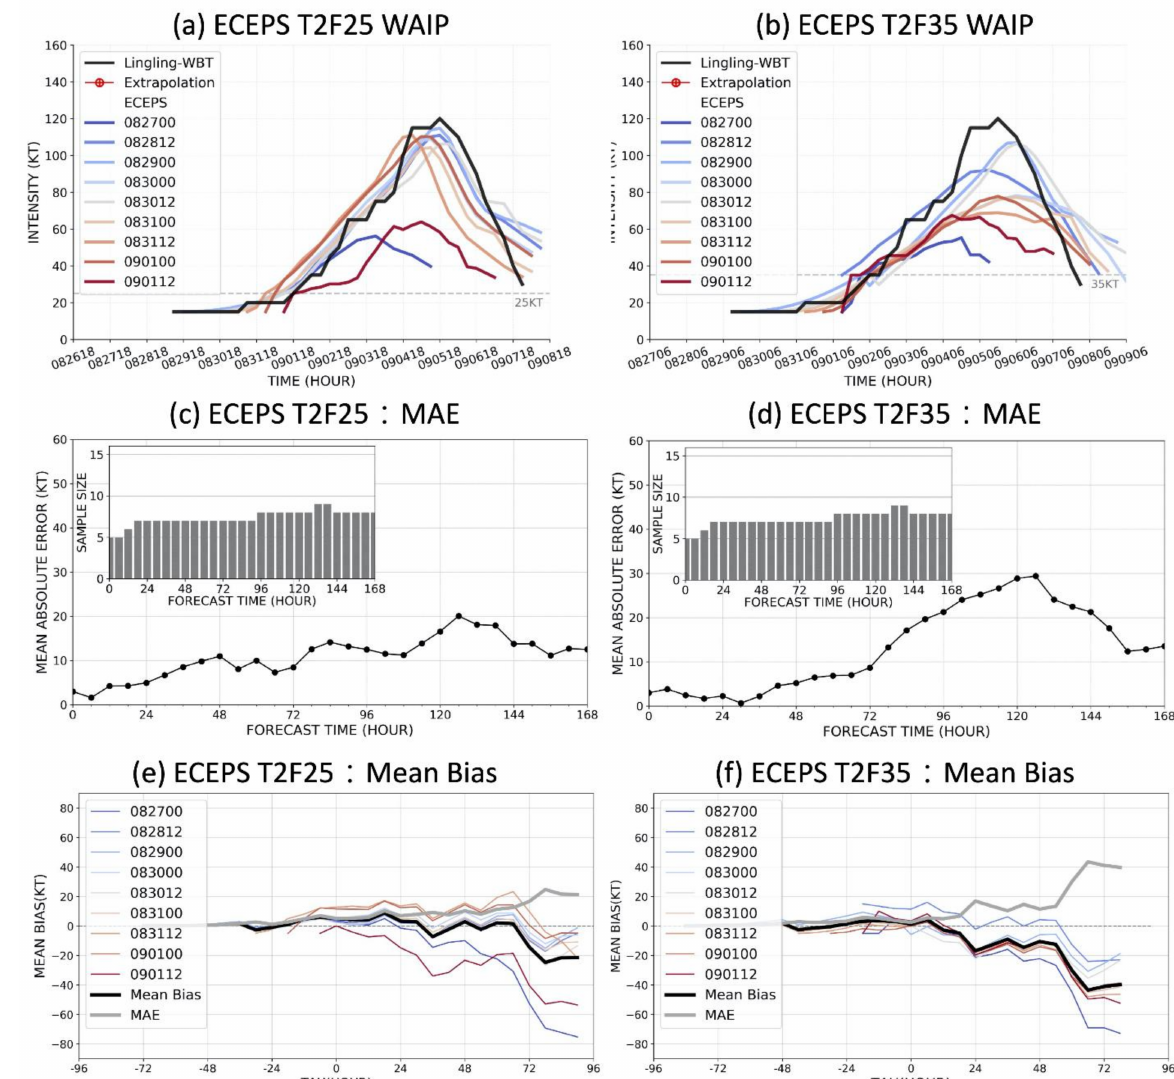
Figure 4. Pre-Lingling circulation modified WAIP intensity (knots) forecast verifications for the ECEPS-predicted T2F (25 kt) in left column and the T2F (35 kt) in right column: ( a , b ) Nine intensity forecasts (see initiation MMDDHH times in inset) versus JTWC WBT intensities in black line; ( c , d ) Intensity Mean Absolute Errors (MAEs) for the sample sizes indicated in the insets; and Mean Bias errors of the individual forecasts (see MMDDHH times in inset) relative to the JTWC WBT for forecast times relative to the ( e ) T2F (25 kt) and ( f ) T2F (35 kt) labeled as tau = 0. When more than one intensity forecast is available at a forecast time, the mean bias (black line) and MAEs (grey line) are